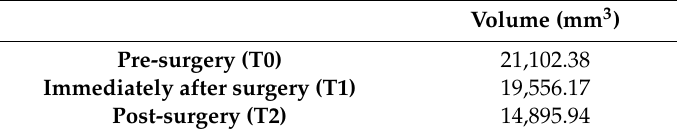
Table 1. Rendering volume of the 3D reconstructed model for pre-surgery, immediately after surgery and post-surgery.